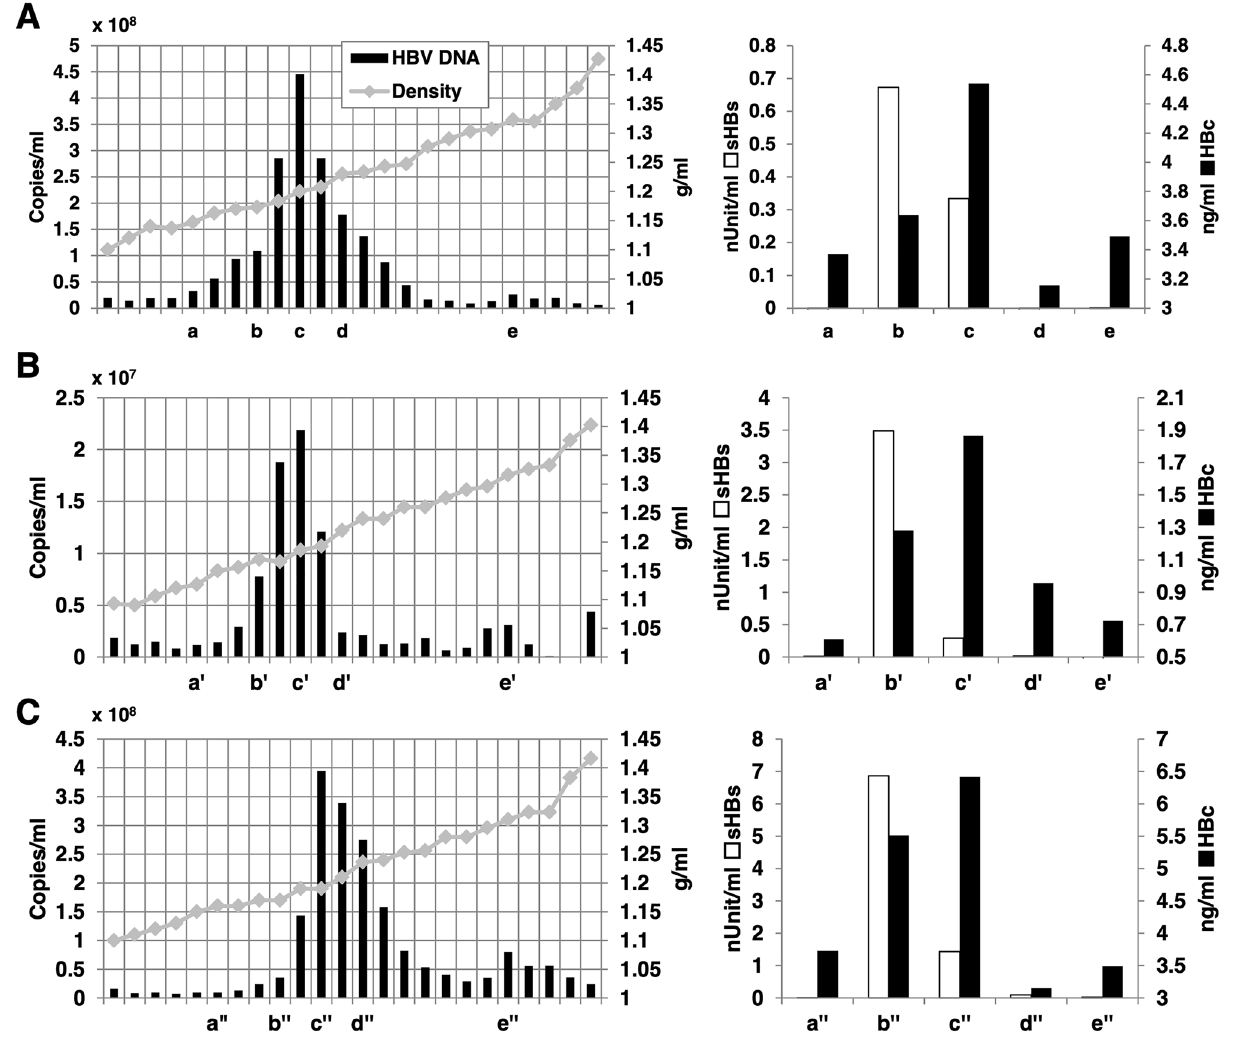
Figure 5. Culture media from 3D-cultured E/NtG8 cells infected with HBVbb ( A ) and HBVcc producing HepG38-7Tet cells ( C ) and serum including HBVbb ( B ) were fractionated by CsCl density gradient ultracentrifugation. For each fraction, the amount of HBV DNA was indicated (black bar) against buoyant density (g/ml, gray dot) (right panels of ( A – C )). The fractions with small letters on horizontal axis were selected for the detection of HBV antigens by ELISA. The amounts of small HBs (SHBs, white bars) and HBc antigens (black bars) in the selected fractions are shown (left panels of ( A – C